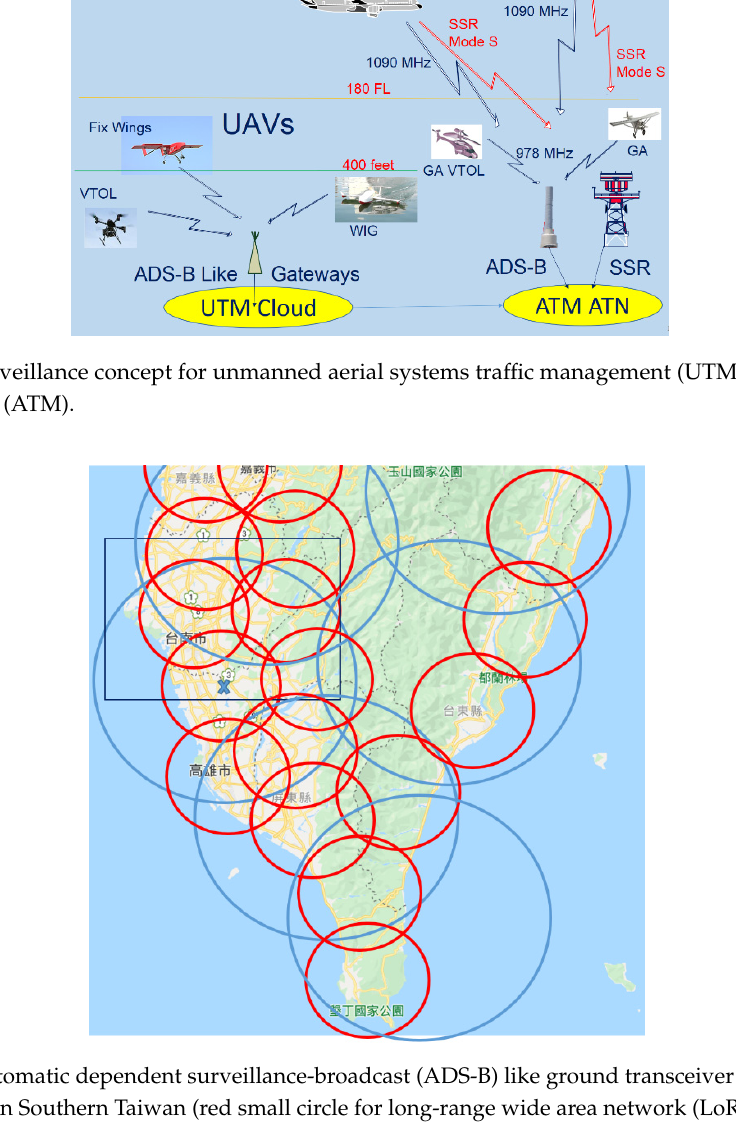
Figure 3. Theoretical altitude coverage of LoRa Gateway (similar to APRS with higher coverage). From the system operation concept, the proposed hierarchical UTM is organized by RUTM and NUTM [3]. All UAV surveillance data will be relayed via GTS into the UTM cloud. The ADS-B like infrastructure is constructed and deployed in Tainan City for RUTM operation. All UAVs will be classified into small rotor wings to fly below 400 feet, or larger fixed wings to fly above 400 feet. All UAVs will fly under surveillance in RUTM to NUTM. An additional concept in Figure 4 expresses the possible connection from UTM to ATM via the air navigation service provider (ANSP) to re- broadcast UAV surveillance data to NAS aircraft. ADS-R frequency 1090 MHz to air transportation aircraft or 978 MHz to general aviation aircraft are re-broadcasted. The traffic alert and collision avoidance (TCAS) together with detect and avoid (DAA) by active avoidance shall be maneuvered by aircraft pilots [20,21].